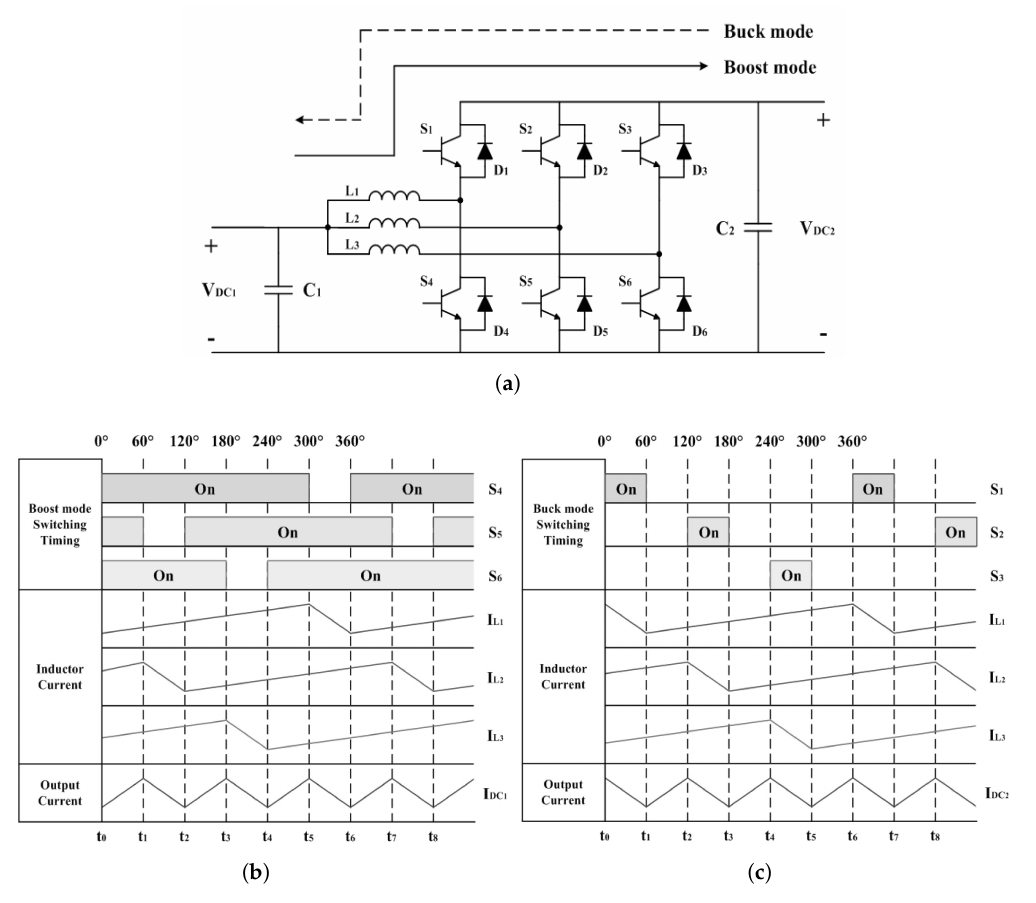
Figure 3. Three branches half-bridge bidirectional DC/DC converter: ( a ) diagram of the converter, ( b ) switching states and currents in boost mode, ( c ) switching states and currents in buck mode